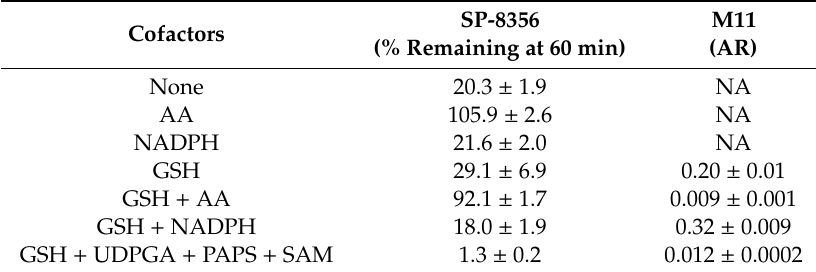
Table 4. Bioactivation of SP-8356 in rat liver S9 fractions.